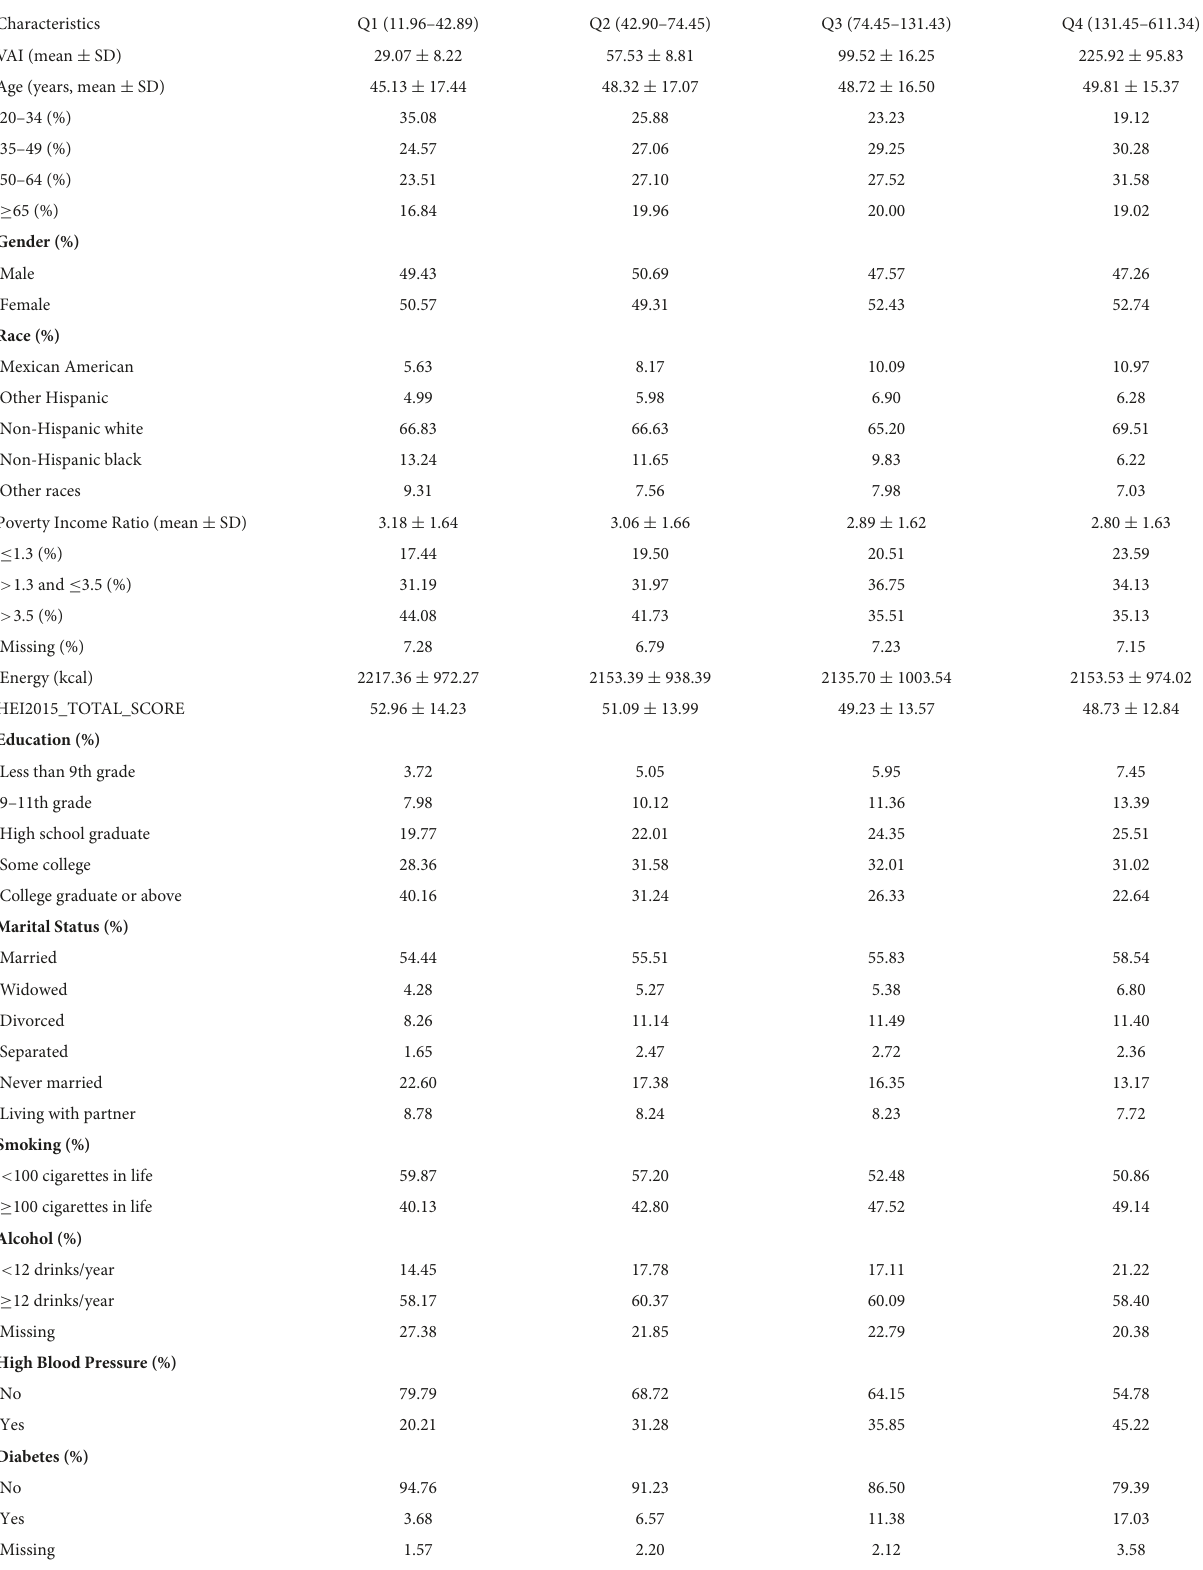
TABLE 1 Characteristics of participants divided by quartile of VAI: NHANES 2007–2018. * †